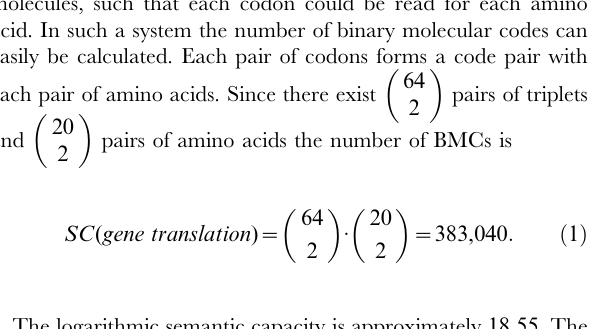
(Table S2, Eq. 4), all possible tRNAs in their unloaded (Table S2, Eq. 5) and loaded form (Table S2, Eq. 6) and all possible aaRS (Table S2, Eq. 7), such that the system is able to load all amino acids to all tRNAs.